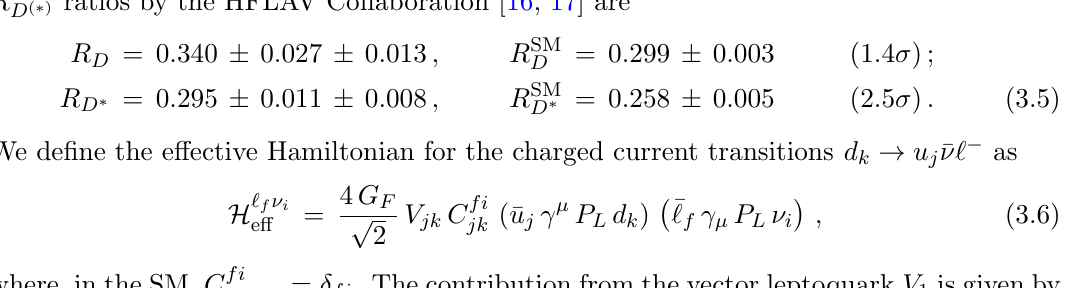
Figure 2 . Likelihood 1 (cid:27) contours from the latest measurements of R ( (cid:3) ) observables, as well as the combined global (cid:12)t (1 (cid:27) and 2 (cid:27) ) in the C (cid:22)(cid:22) the 2D hypothesis C (cid:22)(cid:22) mass scale using the package flavio